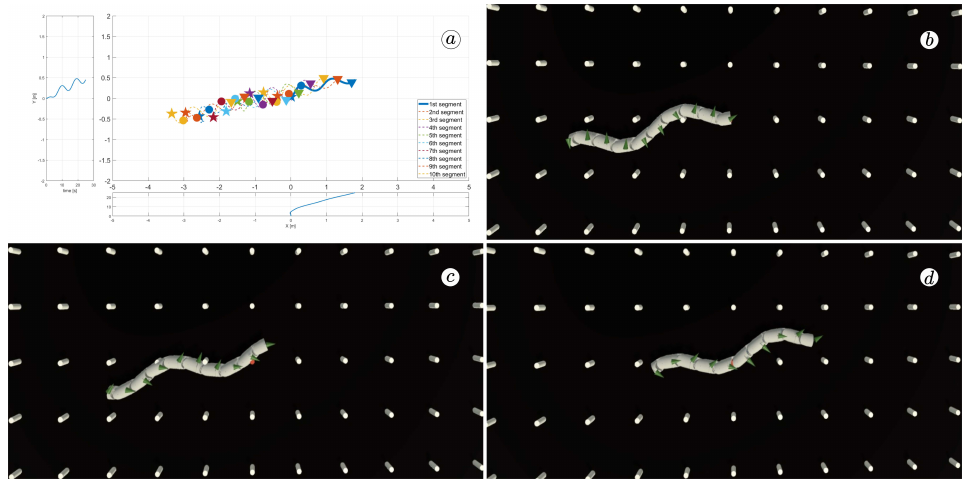
Figure 22. Trajectories of robot segments for φ i ,ref = 40 ◦ sin ( 40 ◦ t + ( i − 1 ) 60 ◦ ) ( a ) and robot configu- rations for t = 5 ( s ) ( b ), t = 10 ( s ) ( c ), and t = 24 ( s ) ( d ).